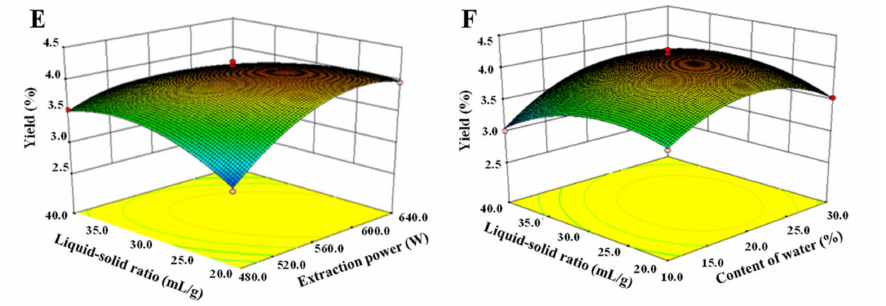
Figure 2. Three-dimensional response surface plots of microwave-assisted deep eutectic solvent extraction. A – F , interactions among extraction time, extraction power, content of water, and liquid– solid ratio, respectively.